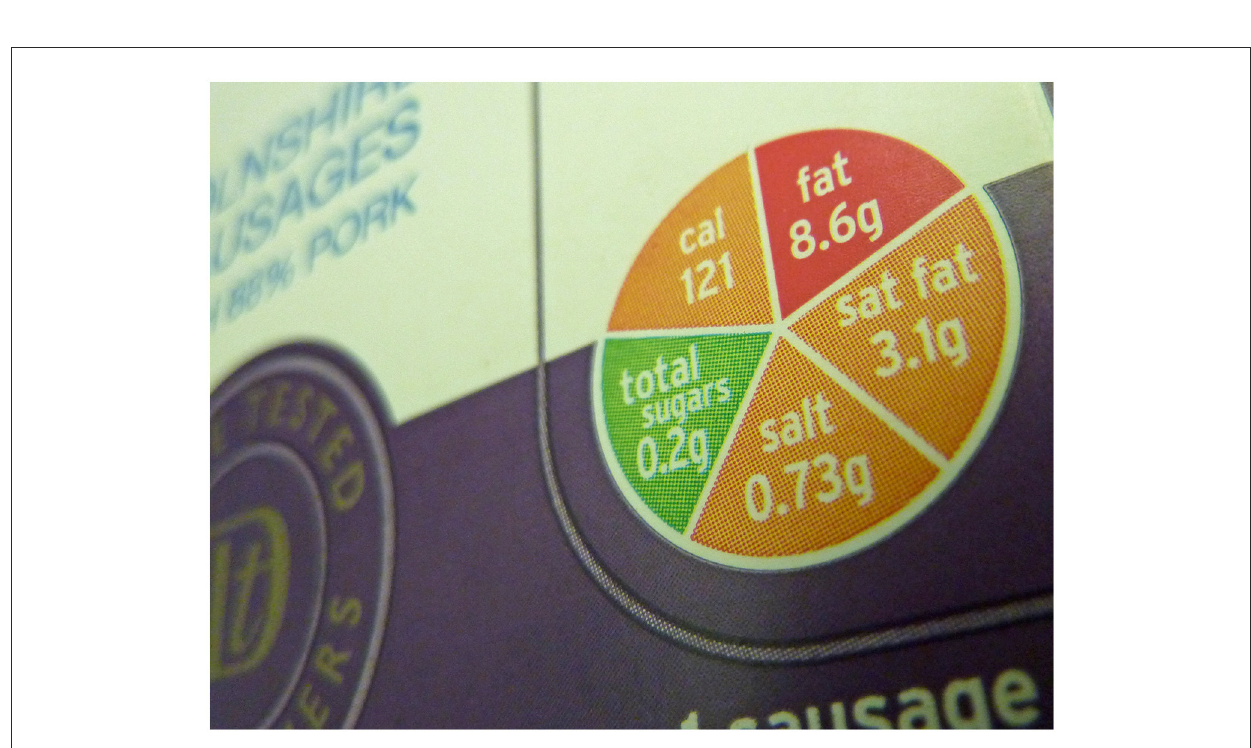
FIGURE3 Traffic light labeling on food. Photograph Ian Clark/ijclark. CC BY-NC